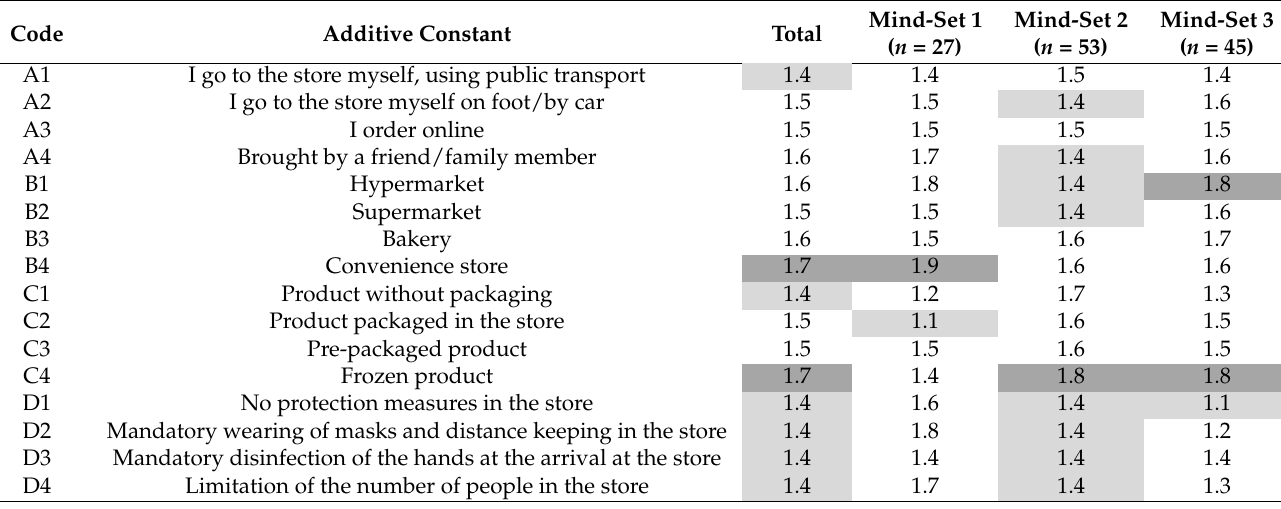
Table 6. Regression coefficients for response times of total panel and the three mindsets. Higher numbers mean slower reactions. The highest numbers of each group are colored as dark gray, while the lowest are colored by light gray. Code Additive Constant Total